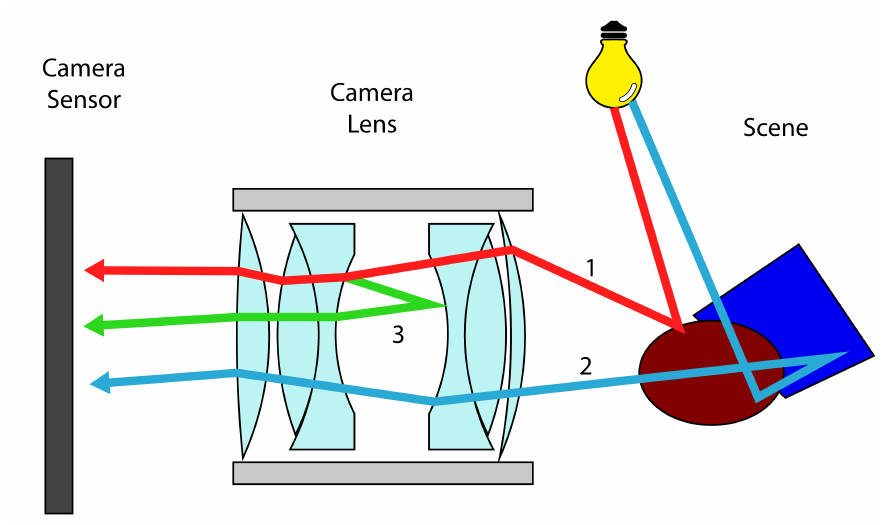
Figure 2. Subdivision of light in three different component [6]: direct light (blue) global light from the scene (red) and global light from the camera lens (green).